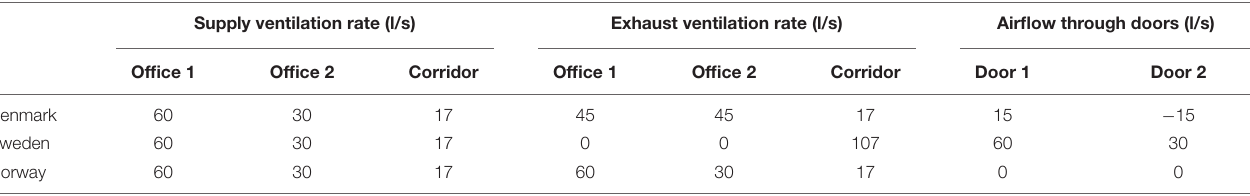
FIGURE 7 | Layout of the office space. TABLE 1 | Ventilation